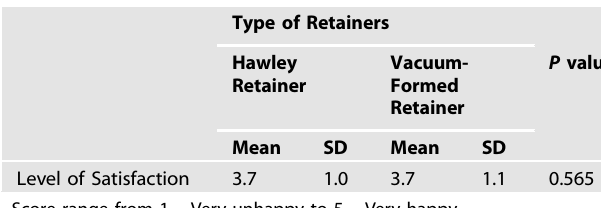
Table 2. Comparison of the level of satisfaction between hawley retainer and vacuum-formed retainer (Independent T-Test) .